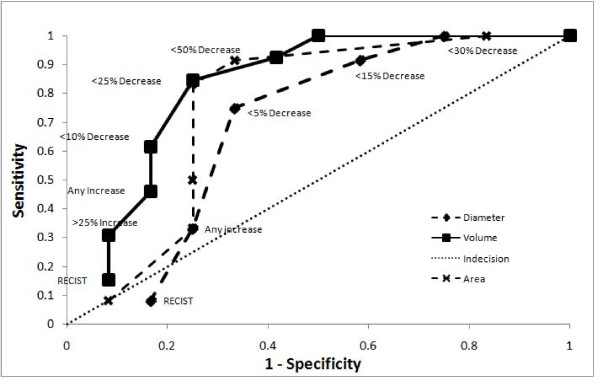
Receiver-Operator Curve by Dimension Metric: Receiver-operator curves for volume (solid, square), area (dashed, cross) and diameter (dashed, diamond) thresholds in predicting 2 year overall survival. Line of indecision is marked as a dotted line.